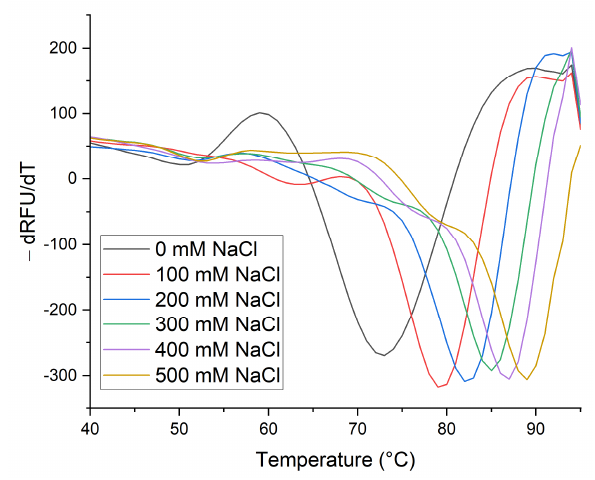
Figure 2. Thermal denaturation of the native protein at pH 7.0 with increasing NaCl concentrations (0 mM; 100 mM; 200 mM; 300 mM; 400 mM; 500 mM). First-order derivatives generated as a function of temperatures.